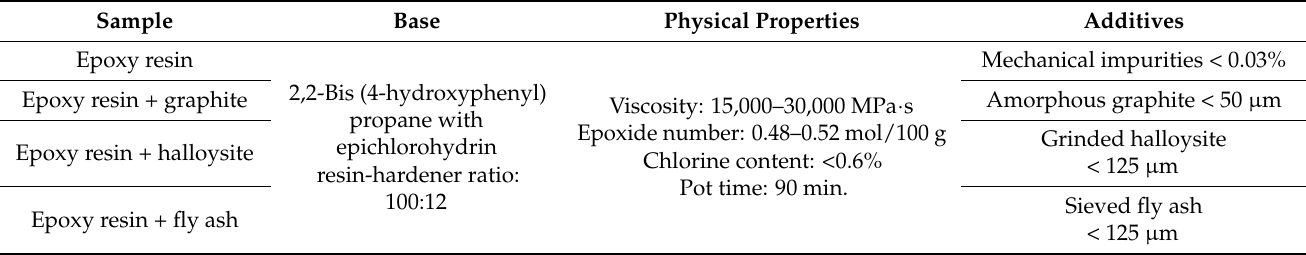
Table 1. Details of investigated samples [26].